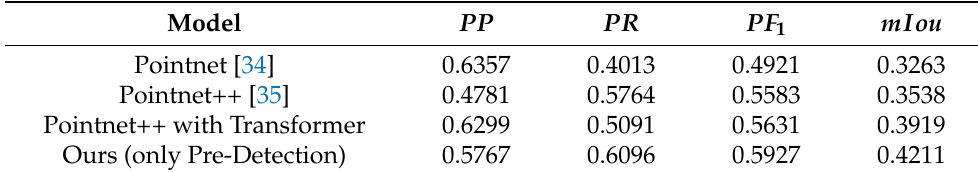
Table 1. Quantitative results of different point cloud semantic segmentation methods on our test dataset. The Point-level Precision ( PP ), the Point-level Recall ( PR ), the Point-level F 1 score ( PF 1 ) and the mean IoU ( mIou ) are reported.